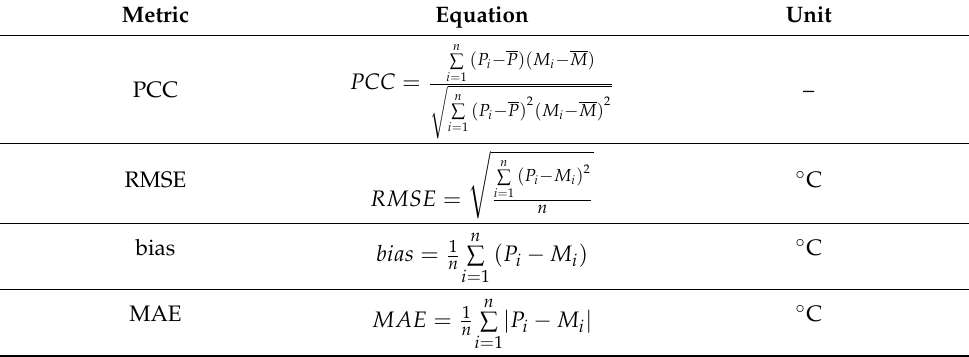
Table 2. The equations and detailed information of PCC, RMSE, bias, and MAE. P i and M i represent the i th downscaled value and ground measurement, respectively. P and M indicate the average values of downscaled temperature and in-situ measurements. n is the number of the